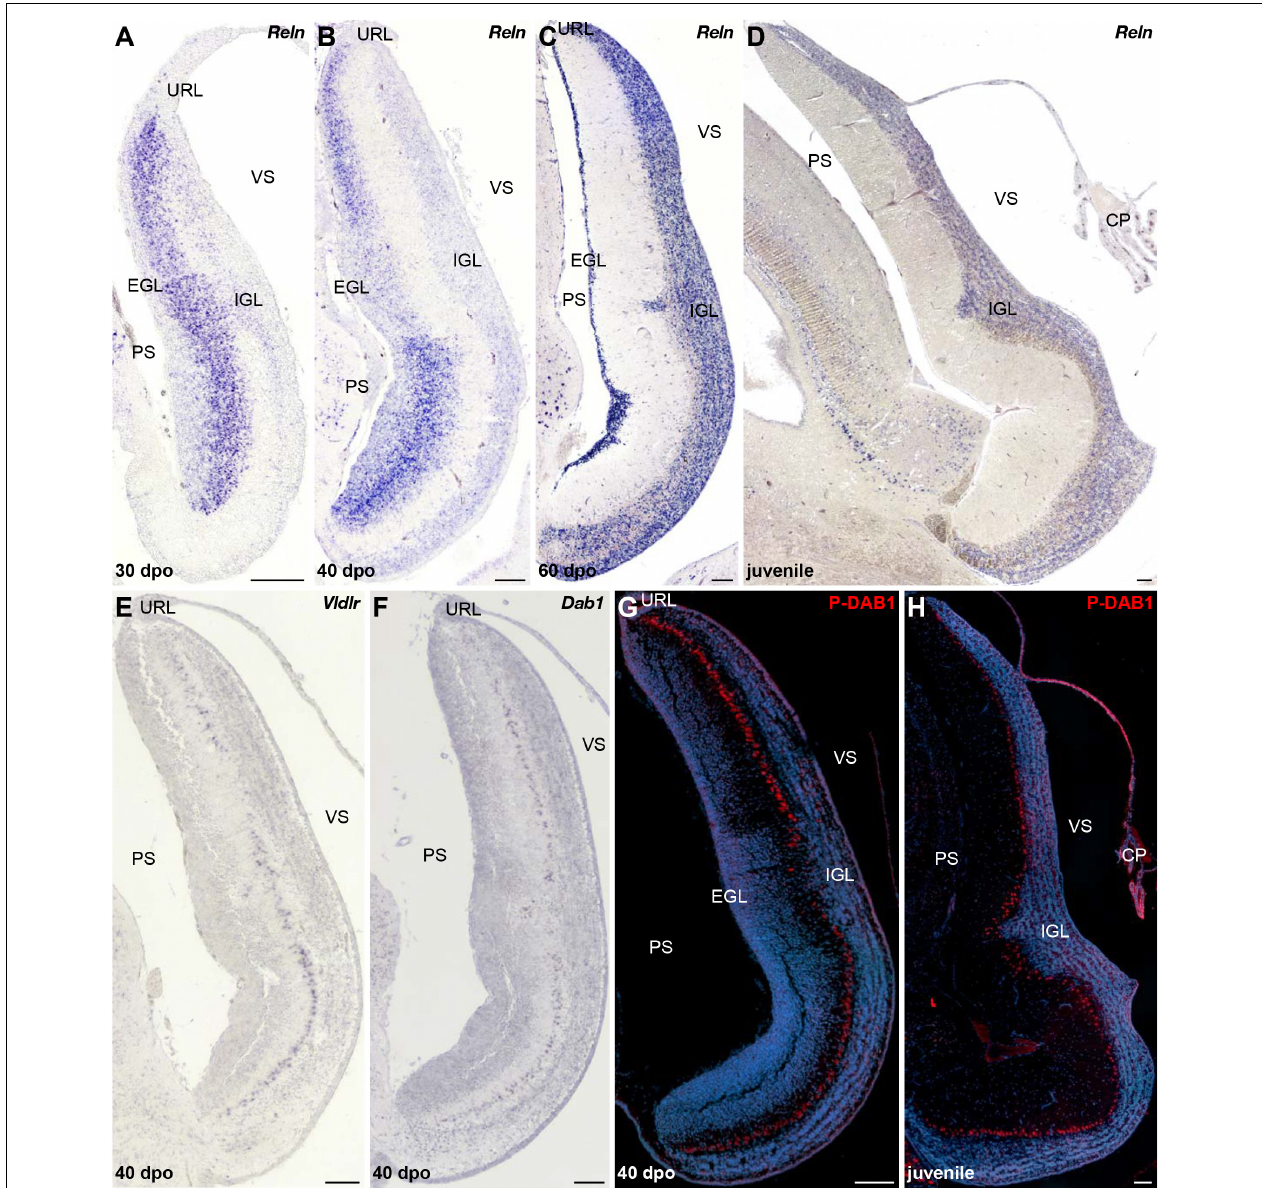
FIGURE 7 | Characterization of RELN signaling pathway in the developing cerebellum of P. vitticeps . (A–D) ISH for Reln at various indicated embryonic (30, 40, and 60 dpo) and juvenile stages in the cerebellum of P. vitticeps . (E,F) ISH for Vldlr (E) or Dab1 (F) at 40 dpo. (G,H) IHC for P-DAB1 (red staining) at 40 dpo (G) and juvenile (H) stages. PS, pial surface; EGL, external granule layer; IGL, internal granule layer; VS, ventricular surface; URL, upper rhombic lip; CP, choroid plexus. Scale bars: 100 µ m.